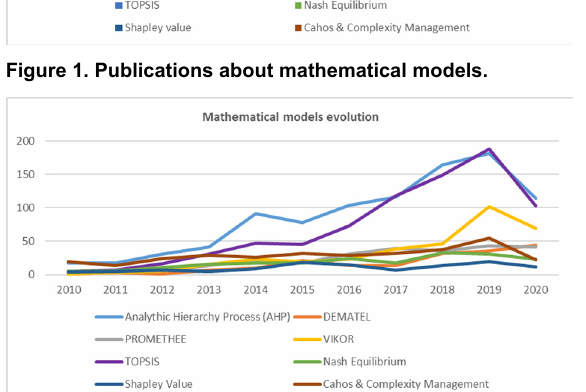
Figure 2. Evolution of mathematical models.